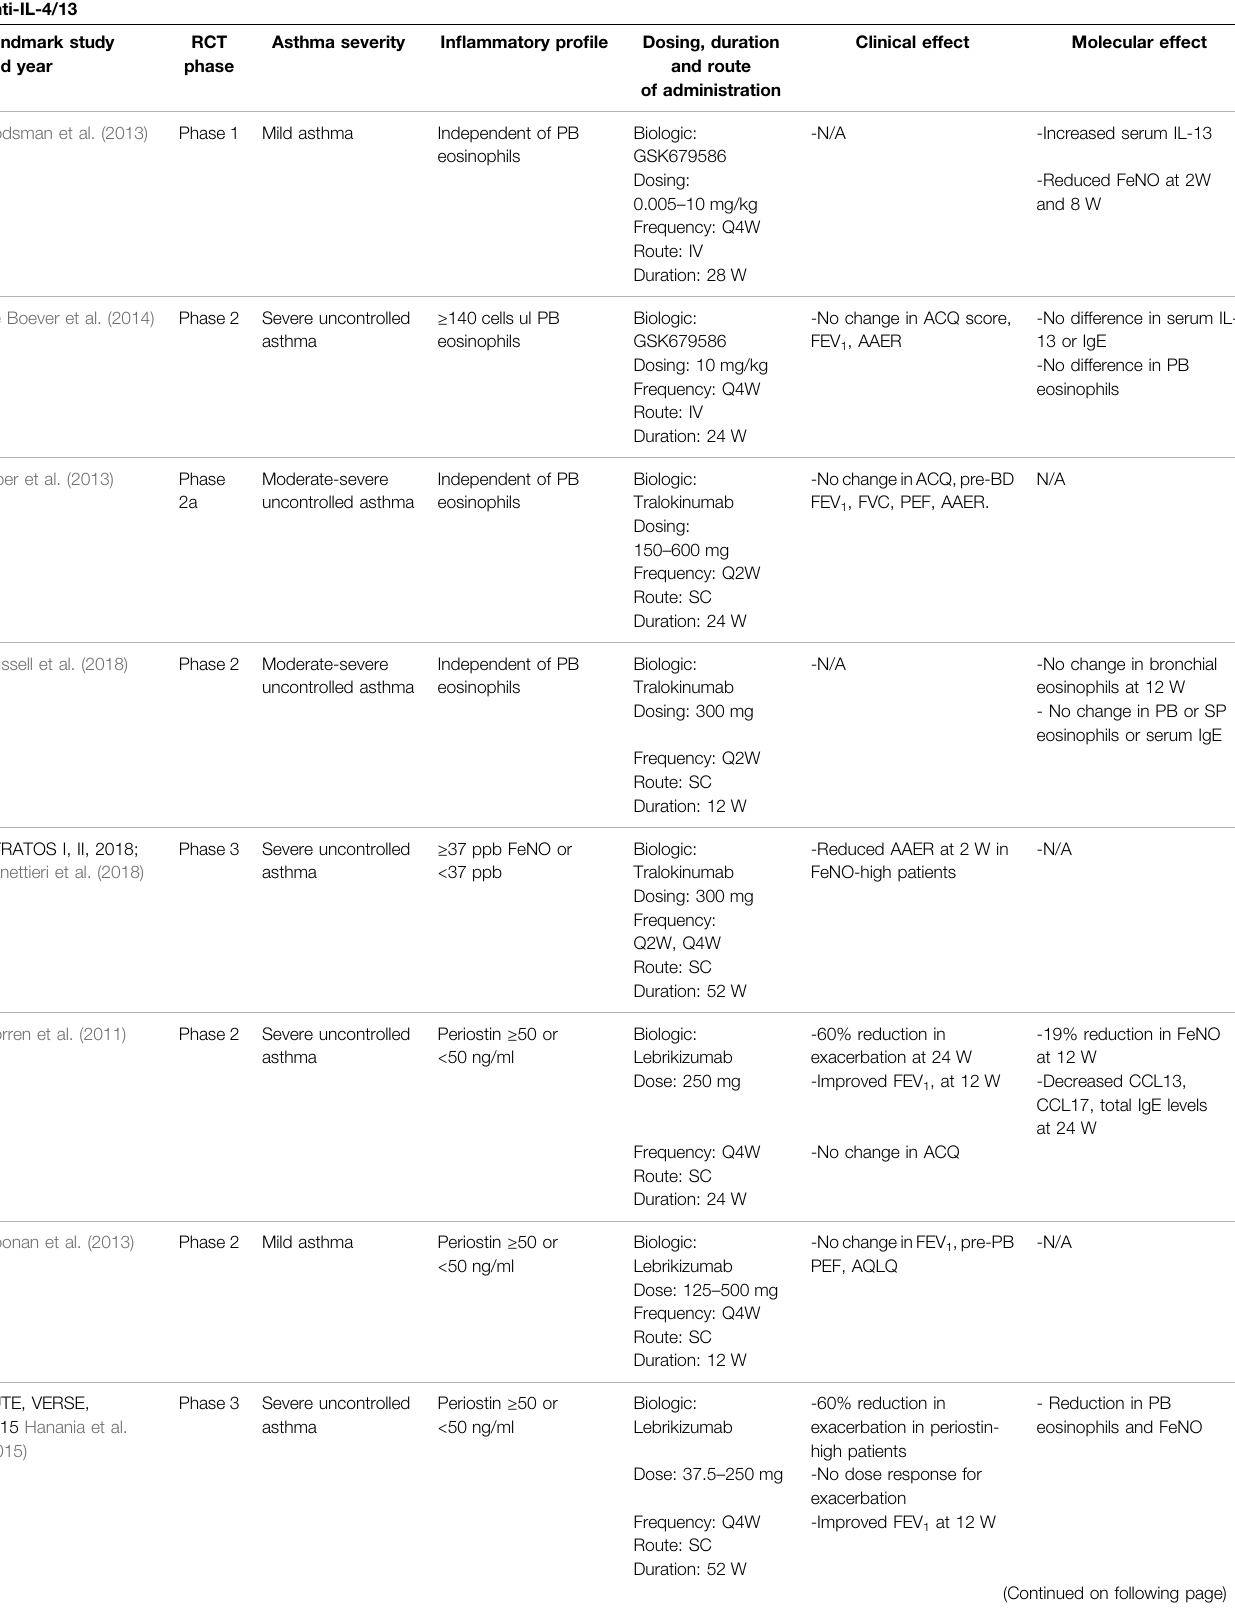
TABLE 5 | Summary of randomized clinical trials assessing IL-4/13 in severe